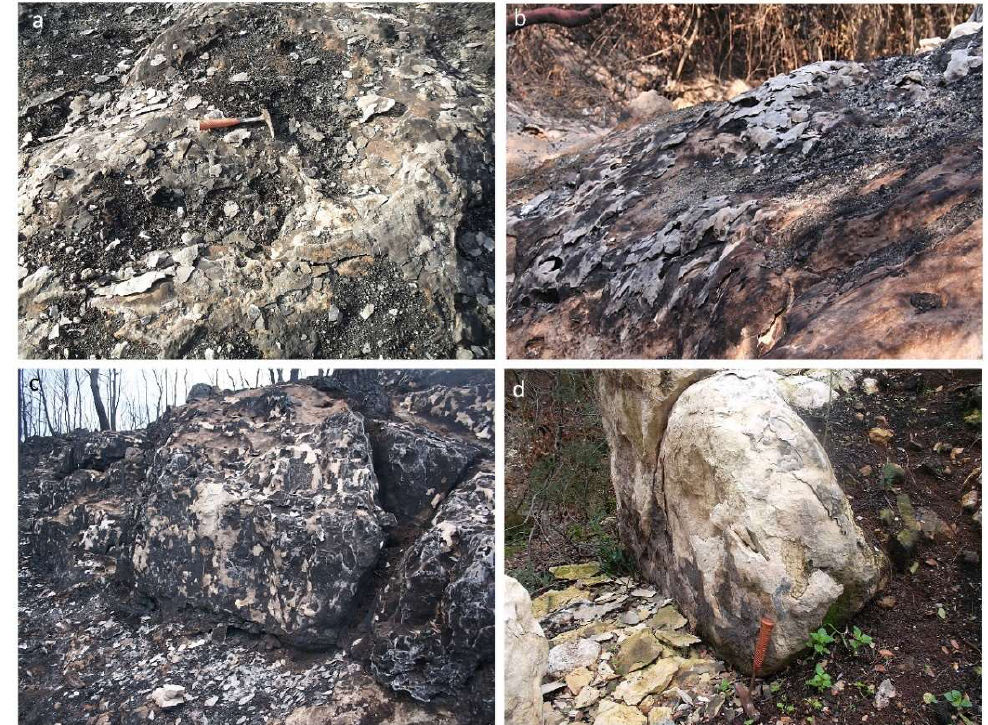
Figure 2. Severe exfoliation of the partially buried rock surfaces: a series of expansion cracks and joints develop roughly parallel to the rock surface, evolving into a series of onion-skin-like sheets or slabs of rock separated by crudely curved, subparallel cracks.